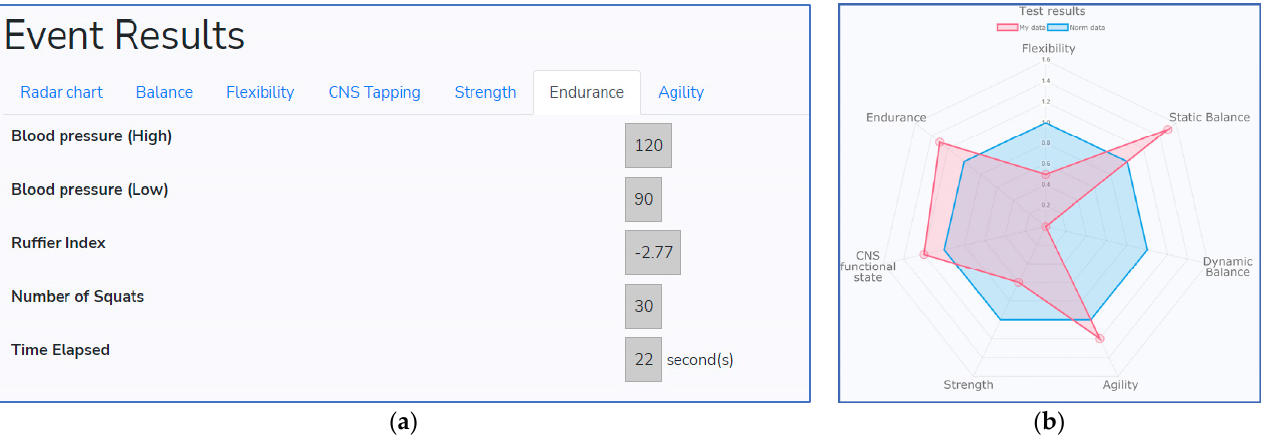
Figure 9. An example of the specialist client device results: ( a ) statistics of the event; ( b ) evaluation results presented as a hexagon web.